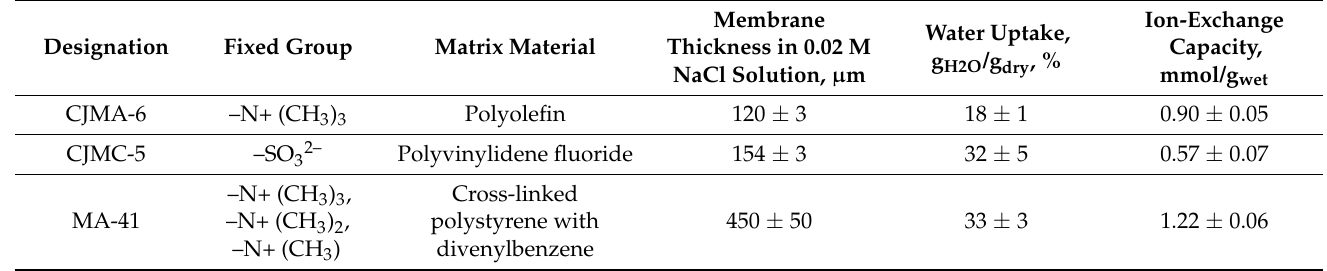
Table 1. Some characteristics of the membranes used in the experiments